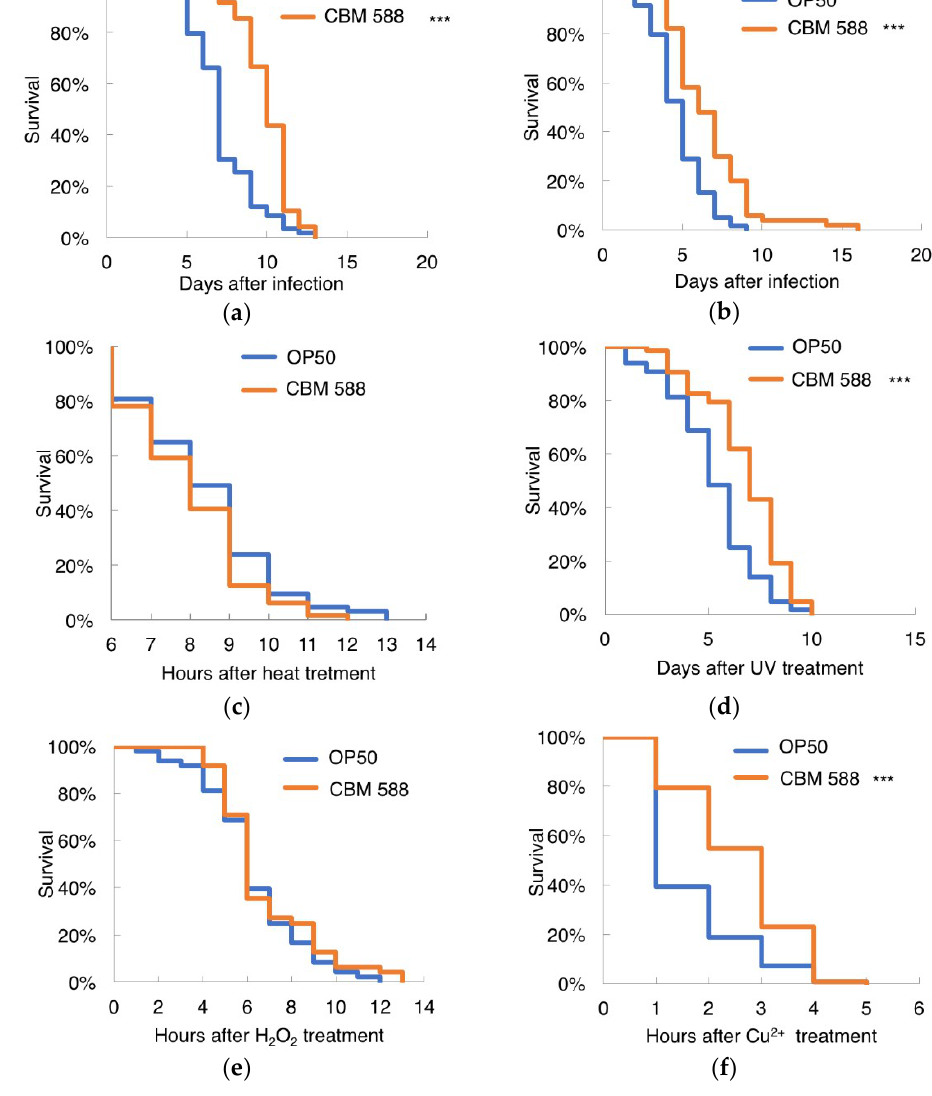
Figure 5. Susceptibility of CBM 588-fed worms to stresses. ( a , b ) Survival of C. elegans infected with pathogenic bacteria, Salmonella enterica ( a ) or Staphylococcus aureus ( b ). ( a ) OP50-fed group, n = 59; CBM 588-fed group, n = 48. ( b ) OP50-fed group, n = 59; CBM 588-fed group, n = 50. ( c – f ) Susceptibility of worms fed CBM 588 to heat stress ( c ), UV irradiation ( d ), hydrogen peroxide ( e ) and Cu 2+ ( f ). ( c ) OP50, n = 64; CBM 588, n = 63. ( d ) OP50, n = 64; CBM 588, n = 63. ( e ) OP50, n = 48; CBM 588, n = 48. ( f ) OP50, n = 63; CBM 588, n = 62. Animals were fed OP50 (control) or CBM 588 from an age of 3 days and then exposed to the individual stresses at the ages described in the Materials and methods. Worms were 7 days old ( a – c ) or 9 days old ( d – f ) on the graph’s nominal Day 0. The survival curves were compared with those of worms fed OP50. *** Statistical significance at p < 0.001, log-rank test.